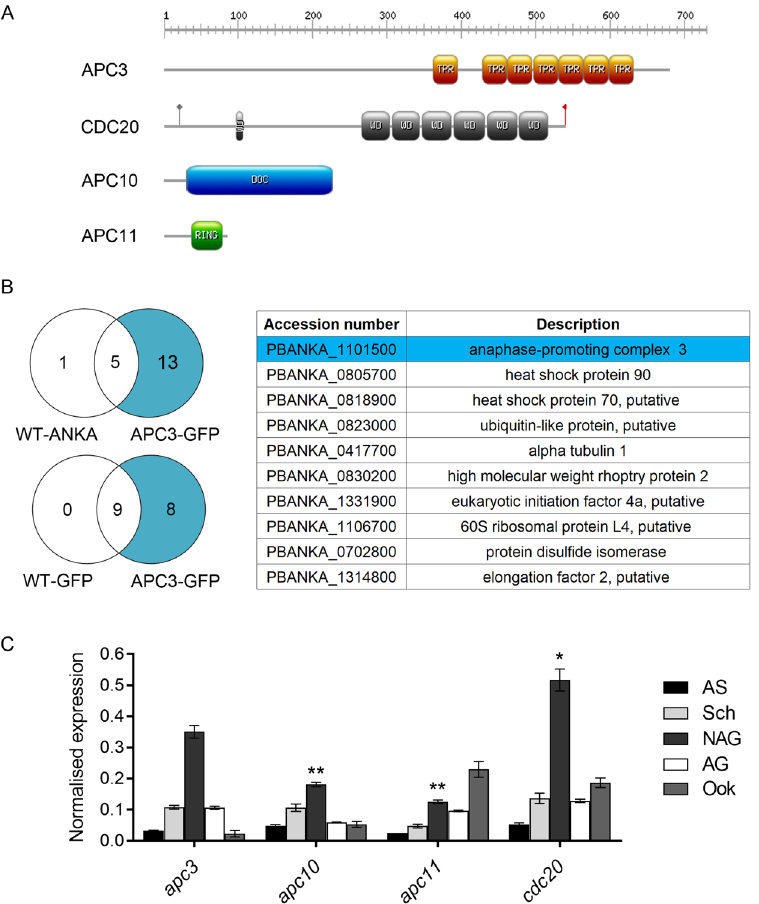
Figure 1. Protein domain analysis, complex formation and transcription. ( A ) Protein domains of the four putative APC/C components. TPR: Tetratricopeptide repeat, WD: WD40 repeat, RING: RING finger. Grey circle: KEN box, Red flag: IR motif. ( B ) Analysis of APC3-GFP by mass spectrometry following immunoprecipitation from a parasite lysate using gametocytes activated for 7 min. Venn diagrams display mean totals of shared and unique proteins compared with WT-GFP (constitutively expressing GFP) and WT-ANKA (without GFP) lines. Table lists unique proteins found only in APC3-GFP samples. Full results can be found in Supplementary Table S1. For APC3-GFP parasite generation see Supplementary Fig. S1. ( C ) Normalised transcript levels of apc3, apc10, apc11 and cdc20 throughout the wild type parasite life cycle analysed by qRT- PCR. Data were normalised against two endogenous control genes, arginine-tRNA synthetase and hsp70 . Each bar is the mean of three biological replicates ± SEM. All asexual blood stages: AS; schizonts: Sch; non-activated gametocytes: NAG; activated gametocytes: AG; ookinete: Ook. Unpaired t -tests were performed between apc3 and the other APC/C components in NAG. * p < 0.05, ** p < 0.001. See also Supplementary Figs. S1 and S2; Supplementary Tables